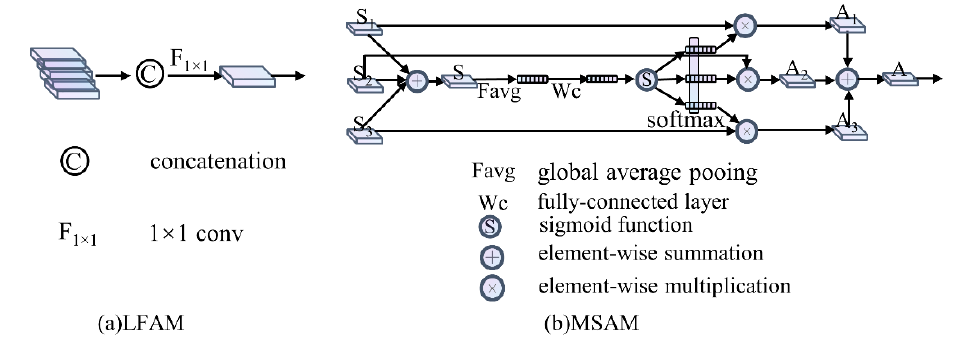
Figure 4. Illustration of LFAM and MSAM.